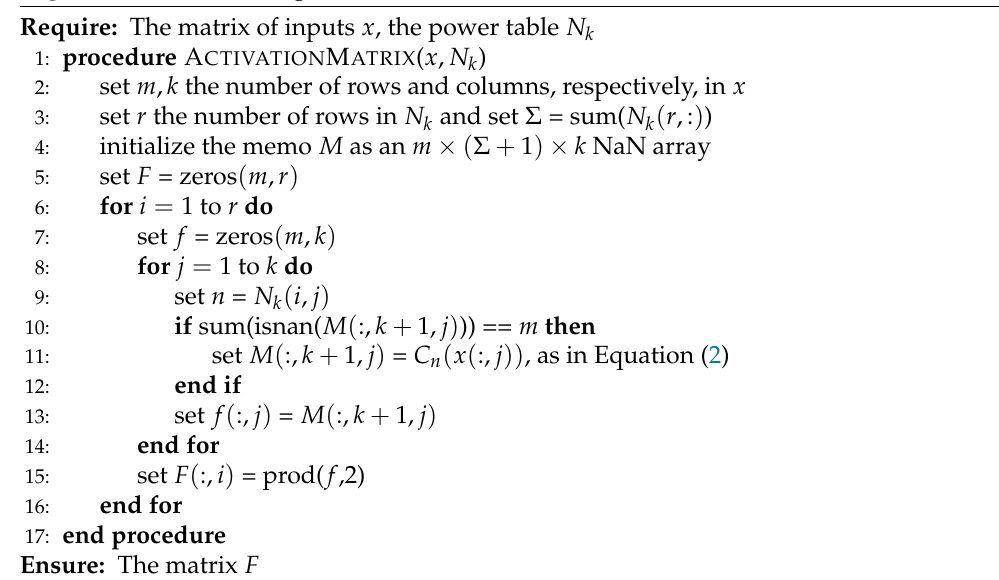
Algorithm 2 Constructing the activation matrix